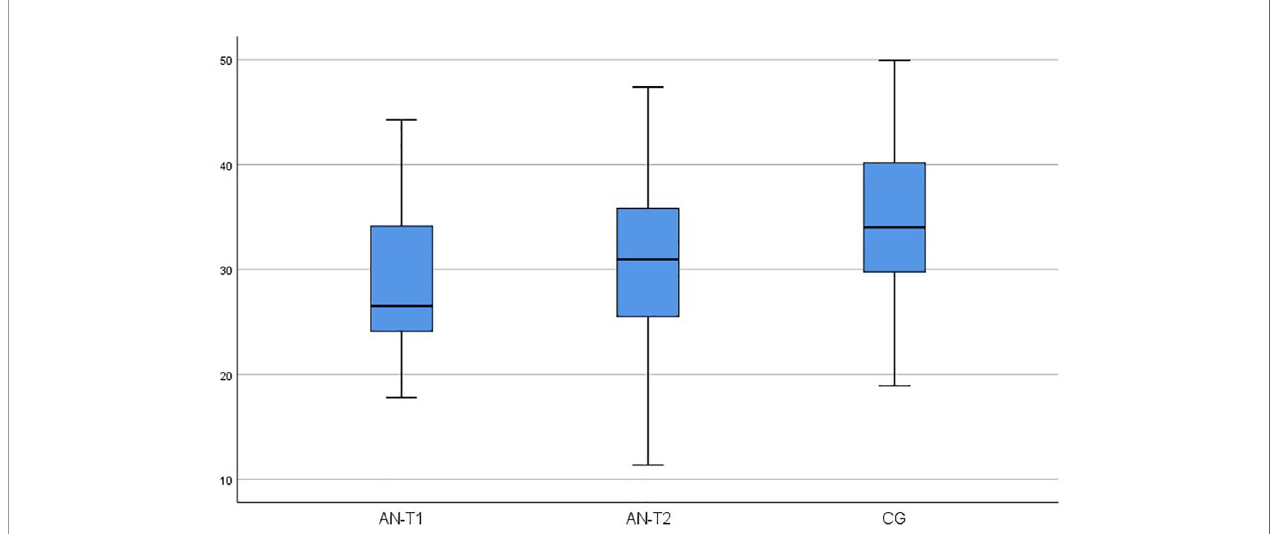
FIGURE 2 | Serum brain-derived neurotrophic factor (BDNF) concentration in adolescent anorexic inpatients in the acute stage of the disease (AN-T1) as well as after partial weight normalization (AN-T2), and in the control group